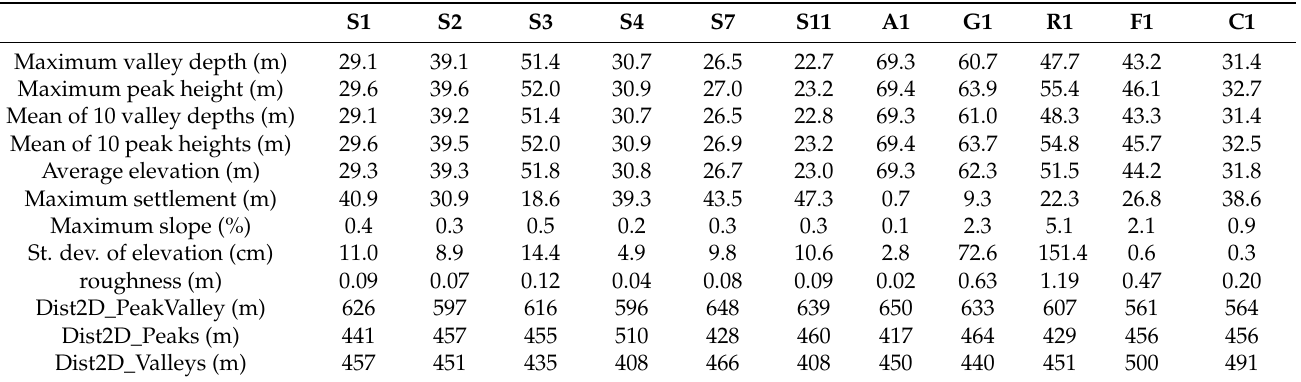
Table 4. Differential settlement analysis for quasi-3D